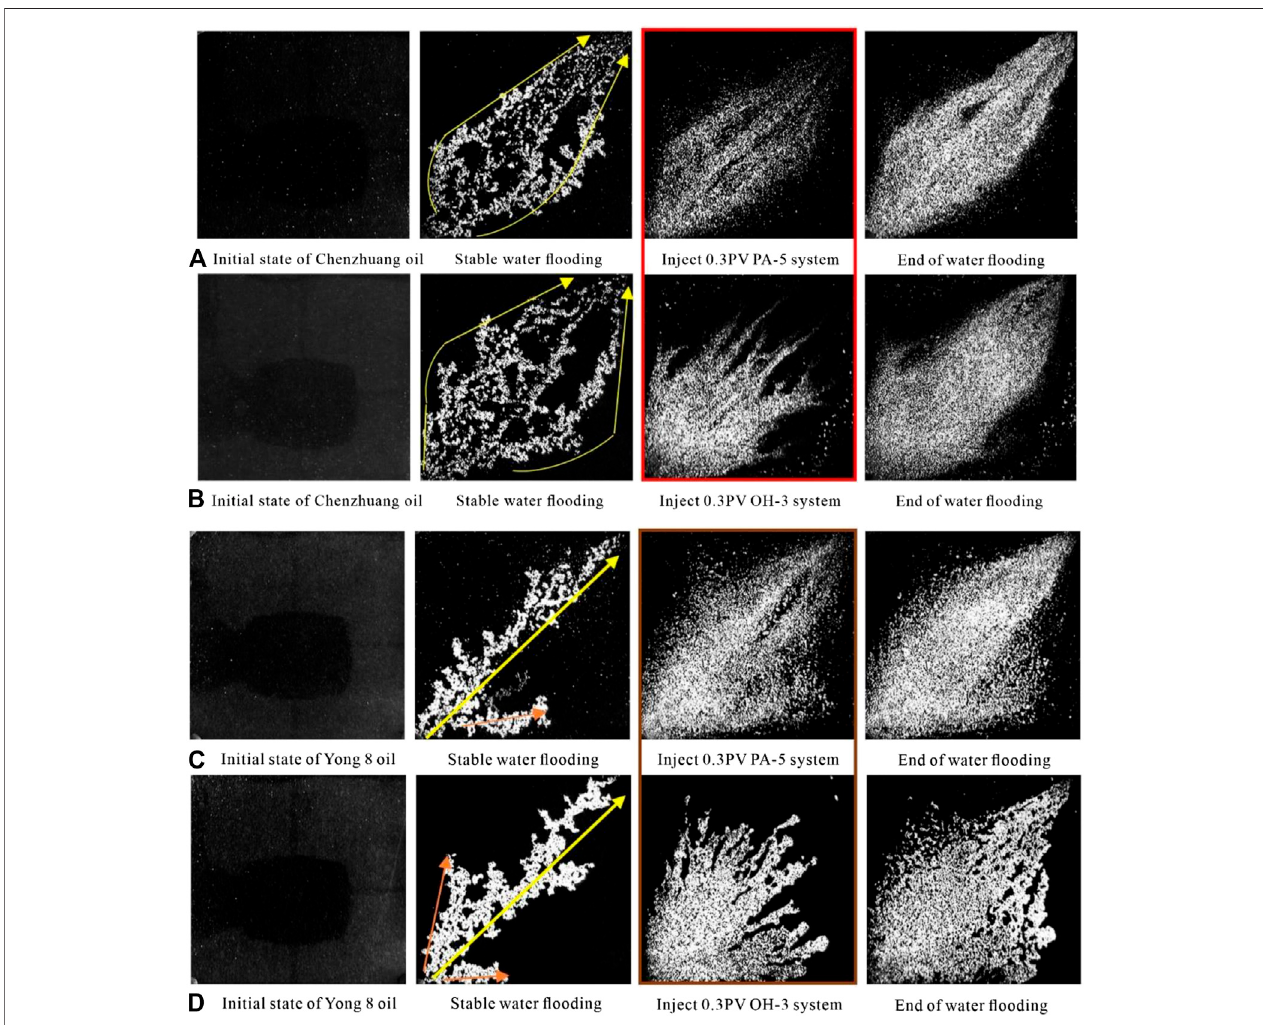
FIGURE 5 | Experimental process of the visualization glass plate homogeneous model. *The yellow arrow is the main channel, the orange is the tributary, the red box is the effect of PA-5 and OH-3 on Chenzhuang oil, and the brown box is the effect of PA-5 and OH-3 on Yong eight oil.